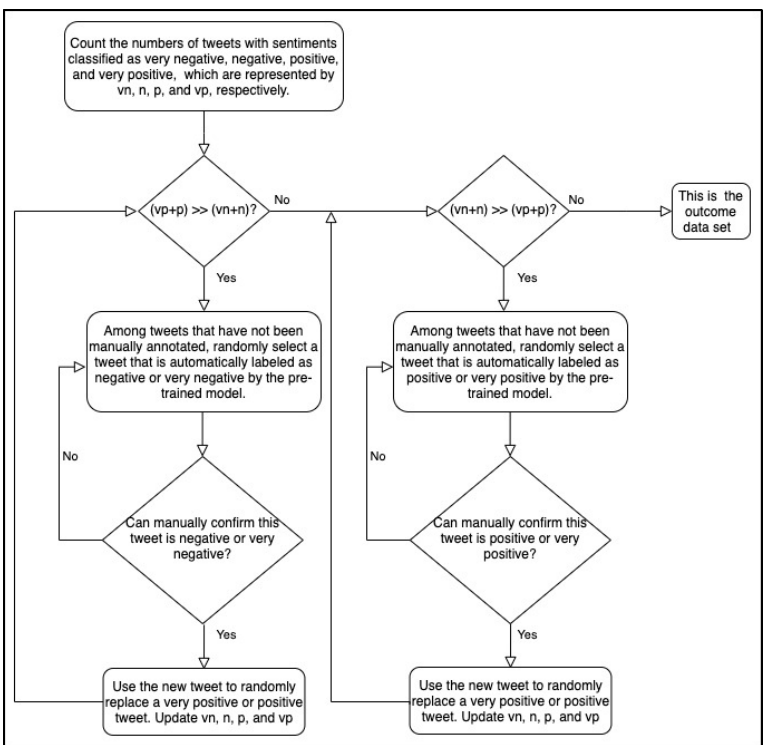
Figure 1. Brief pipeline of the preprocessing method with the close mode. The close mode requires the number of negative and very negative samples to be close to that of positive and very positive samples. Therefore, the resulting data set of the close mode is close to being balanced.